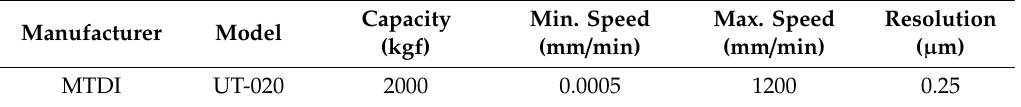
Table 4. Specification of universal test machine.